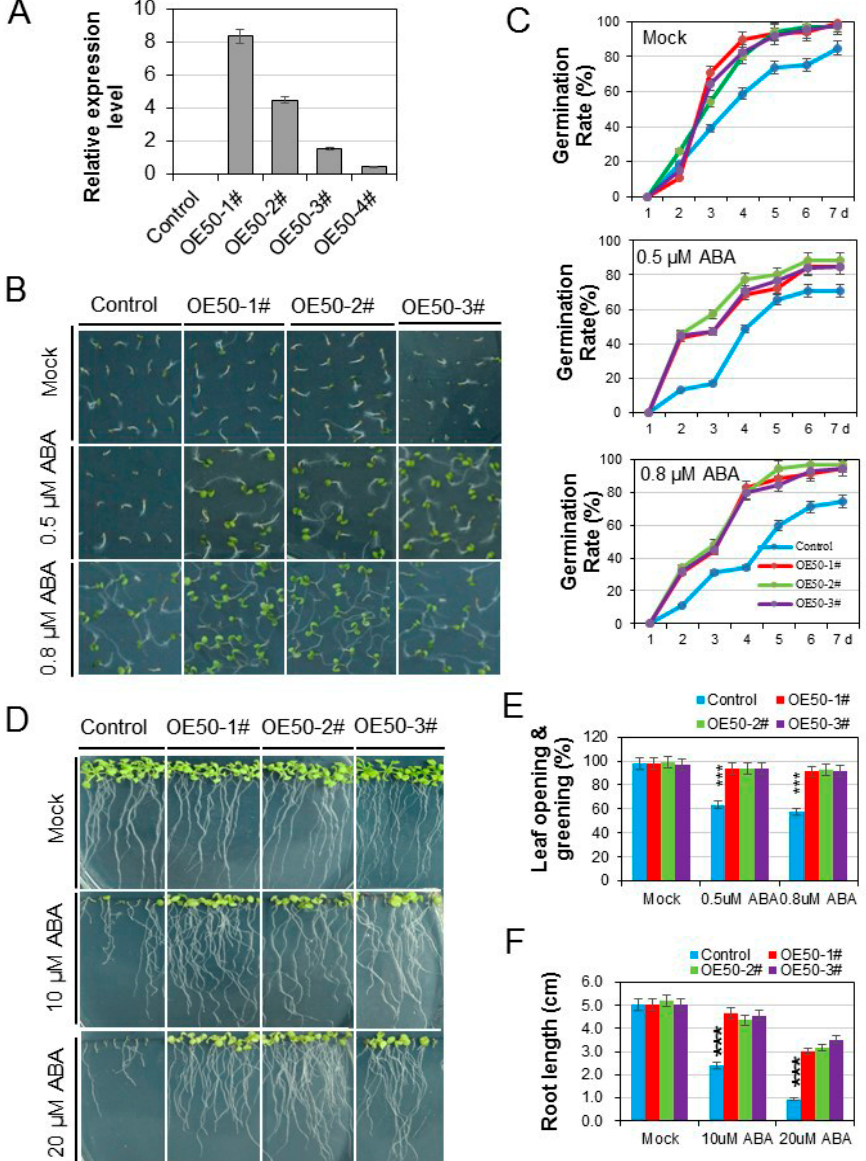
Figure 4. Overexpression of HcWRKY50 in Arabidopsis reduced plant sensitivity to ABA. ( A ) qRT-PCR analysis of HcWRKY50 transcript levels in the homozygous 35S::HcWRKY50 line. Actin 2/7 were used as normalization factors for qRT-PCR. ( B , C , E ) The seed germination rate, the quantitative evaluation of leaf opening, and the greening rate on 1/2 MS with or without different concentrations of ABA in different HcWRKY50 transgenic lines (OE50-1#, OE50-2#, and OE50-3#) and control lines. Photographs were taken 7 d after sowing. ( D , F ) Five-day-old seedlings grown on 1/2 MS were transferred to new plates supplemented with 0, 10, and 20 μ M ABA. The roots of transgenic and control seedlings grown on ABA supplemented plates were photographed and measured. All values are means (±SD) from three independent experiments. *** p < 0.01 by ANOVA analysis.